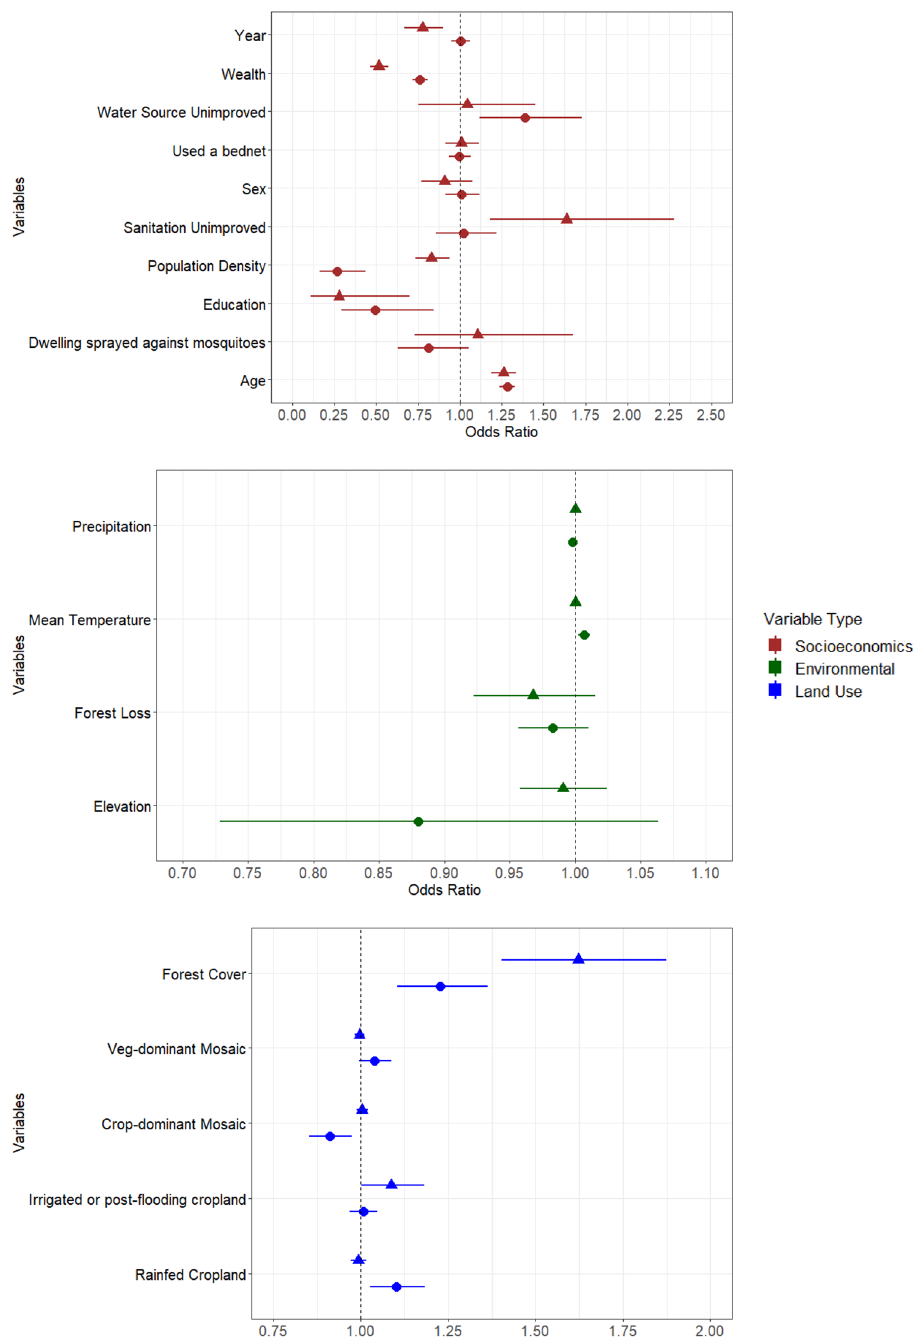
Figure 5. Stratified multivariate analysis of rural and urban households. Factors associated with the odds of childhood malaria differ between rural and urban households. Error bars are defined as the 95% confidence interval. Variables increasing childhood malaria have odds ratios greater than 1 to the right of the vertical line. Crop-dominated mosaic denotes mosaic cropland and veg-dominated mosaic denotes mosaic natural vegetation within the European Space Agency (ESA) Climate Change Initiative Land Cover (CCI-LC)